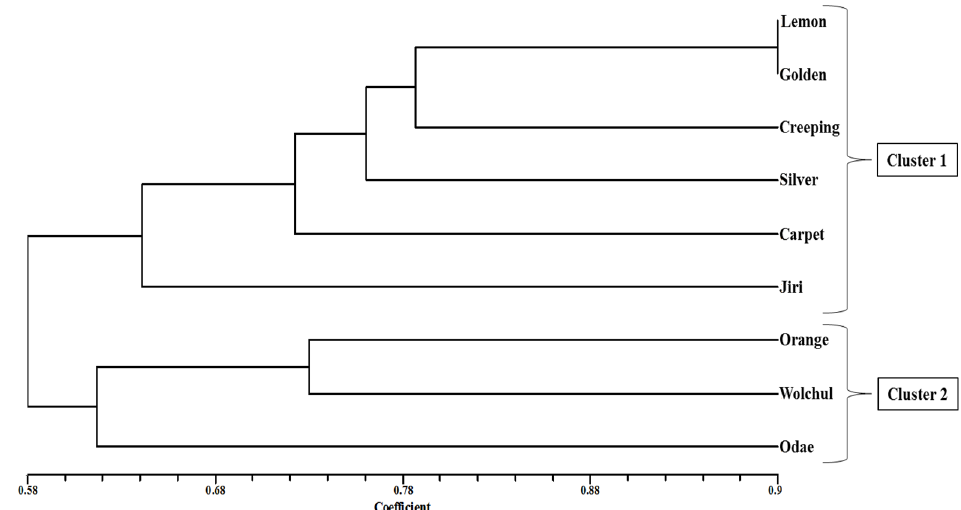
Figure 5. Clustering tree of the three Thymus quinquecostatus cultivars and the six commercial Thymus vulgaris cultivars, based on the unweighted pair-group method with the arithmetic average (UPGMA), using 16 RAPD markers.